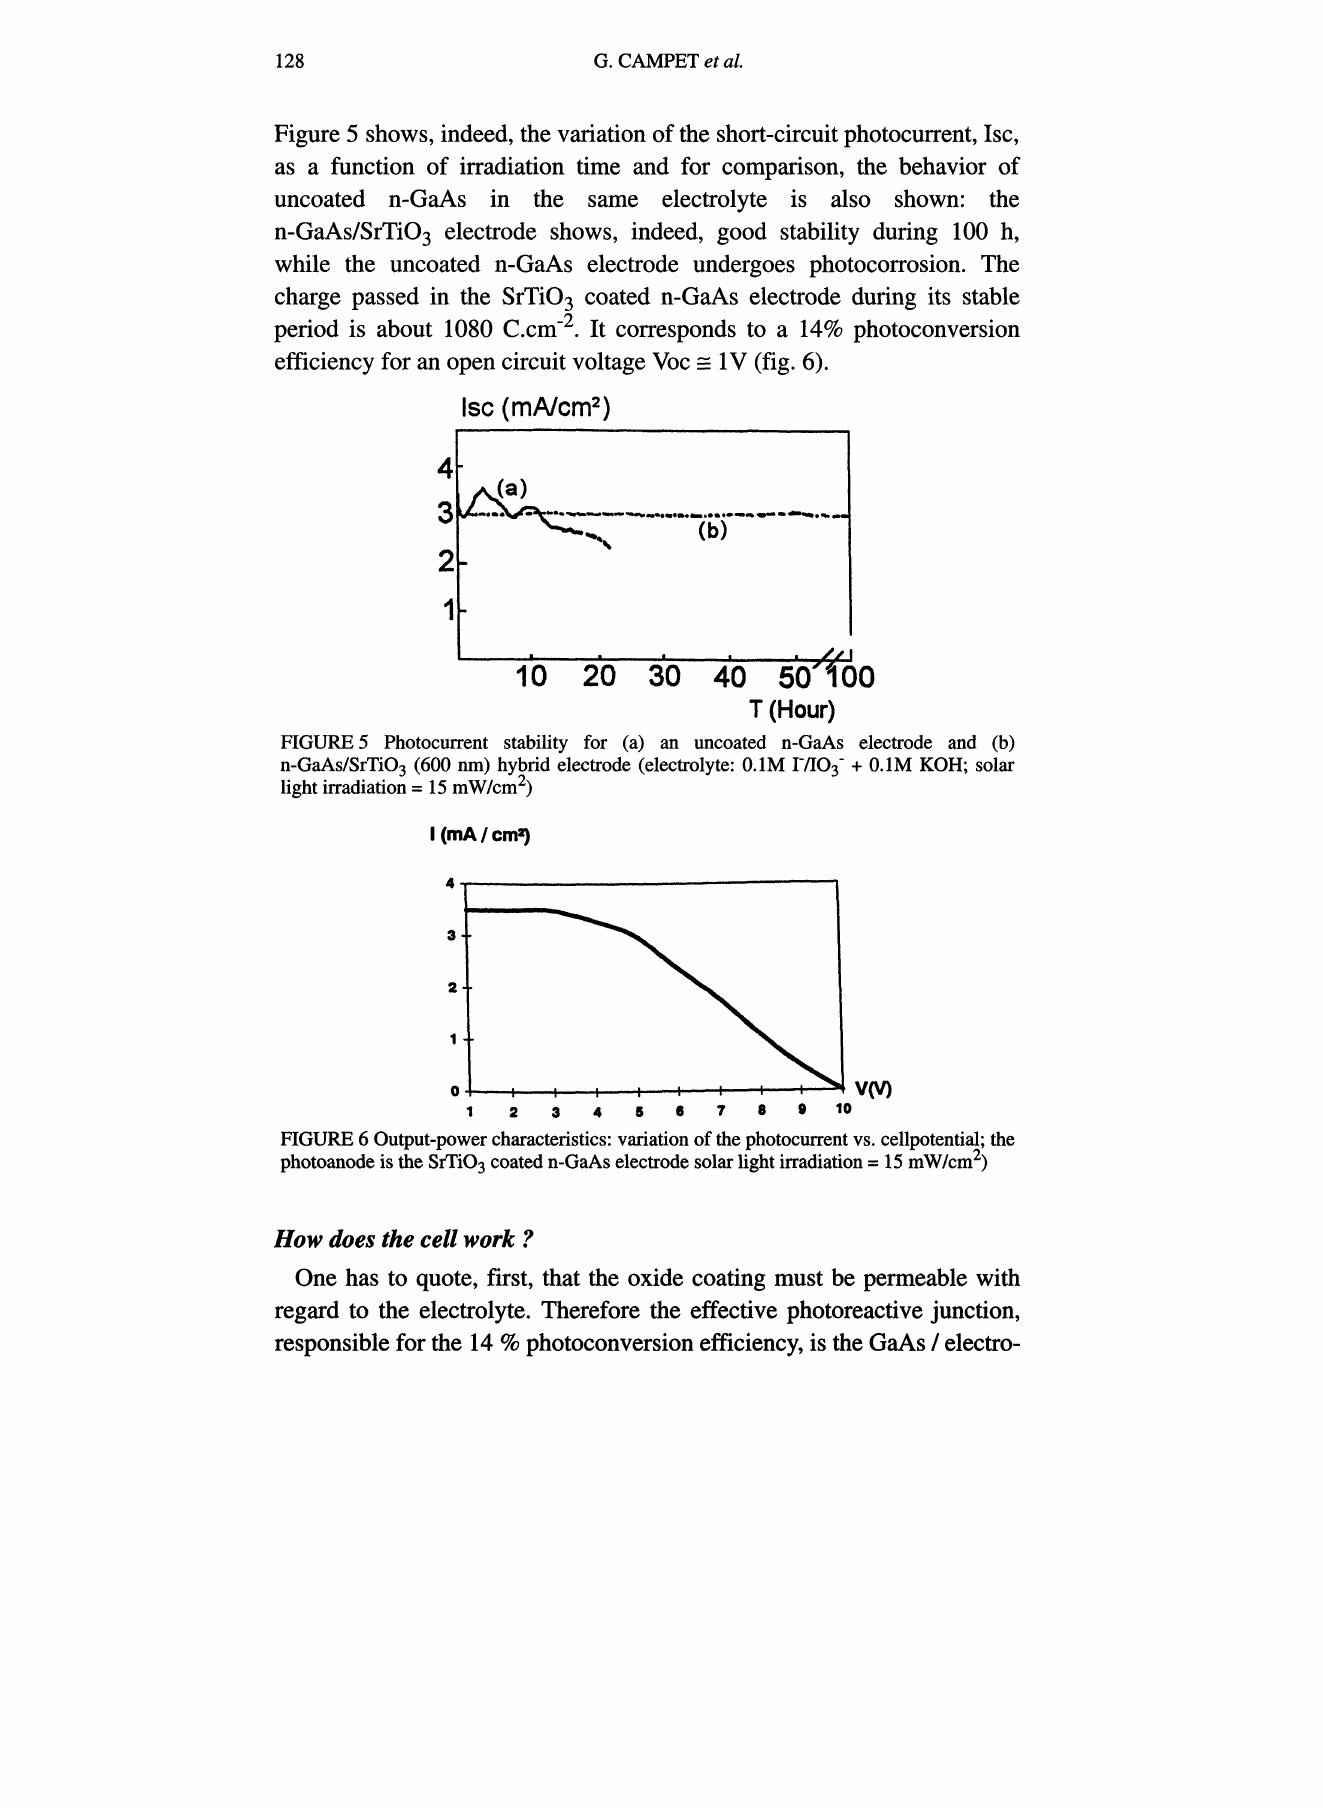
FIGURE 6 Output-power characteristics: variation of the photocurrent vs. cellpotential; the photoanode is the SrTiO coated n-GaAs electrode solar light irradiation 15 mW/cm 2) How does the cell work